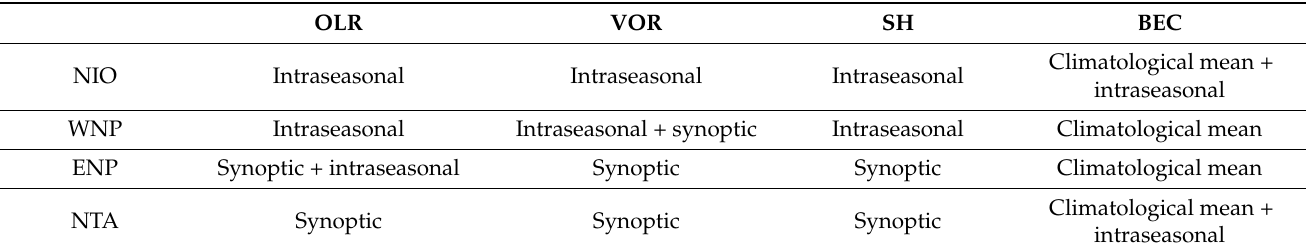
Table 1. Summary of the primary contribution components of OLR, relative vorticity (VOR), specific humidity (SH), and barotropic energy conversion (BEC) to tropical cyclogenesis over the NIO, WNP, ENP, and NTA.